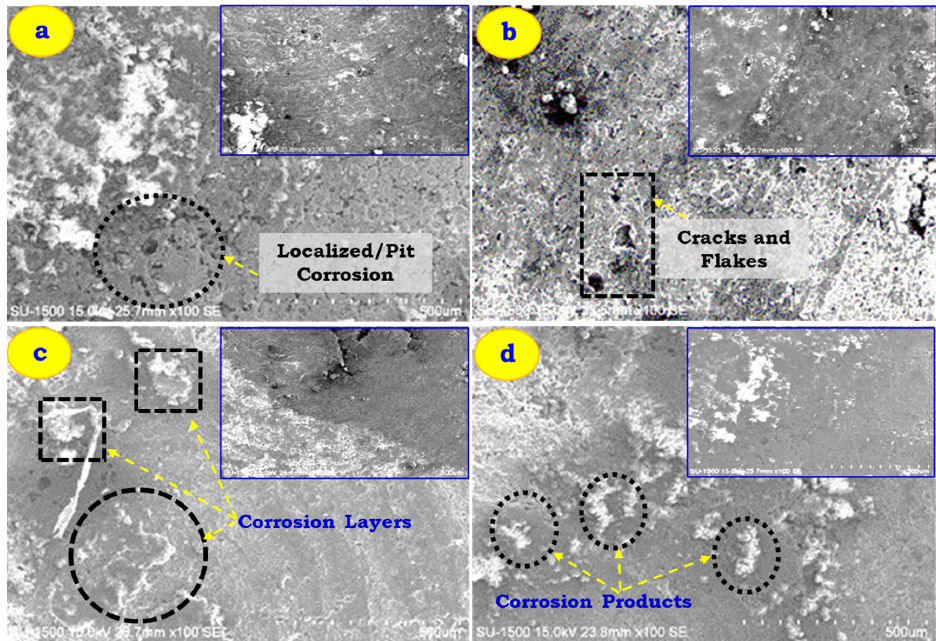
Figure 7. Corrosion morphology in as-cast and extruded (ER: 5.32:1) Al 7005 and its composites immersed in 120 h in 1 M HCl solution (right top image are not extruded corroded samples) ( a ) Al 7005, ( b ) Al 7005 + 5% GF, ( c ) Al 7005 + 6% FA and ( d ) Al 7005 + 6% FA + 5% GF.